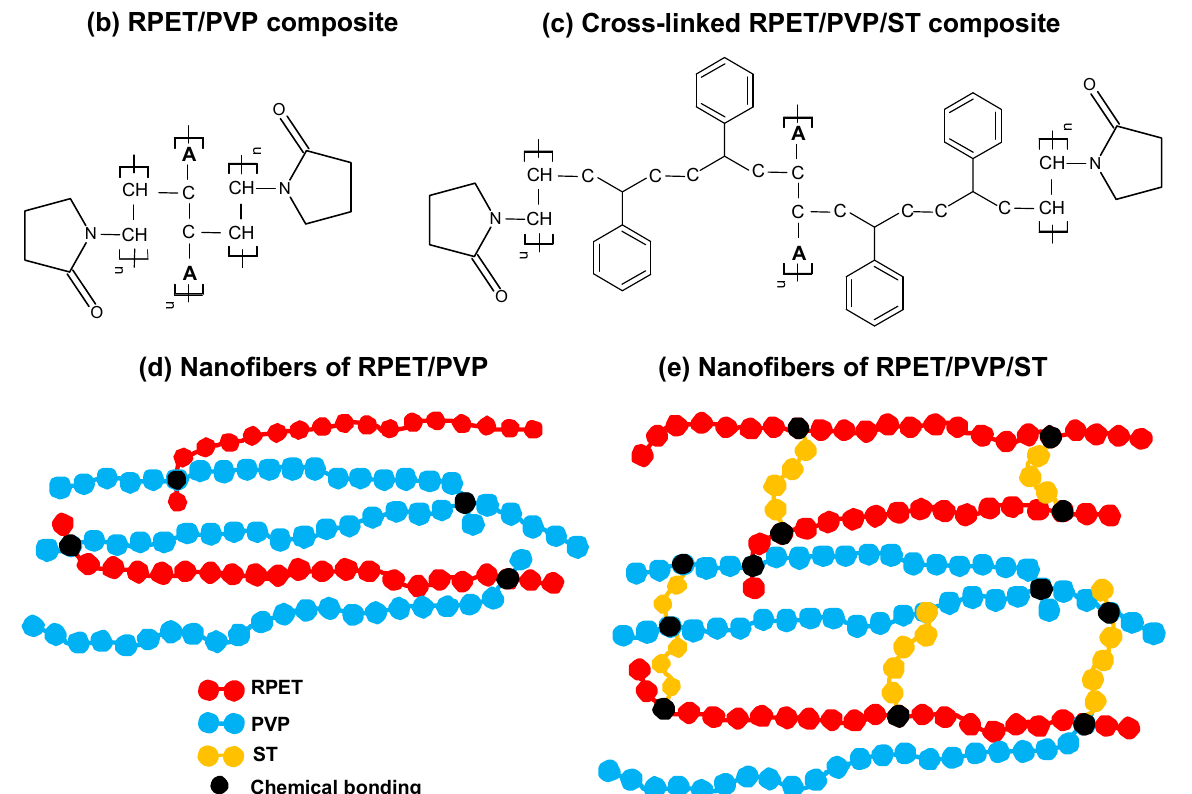
Figure 6. Mechanism of the reaction of nanofibers: ( a ) Generation of free radicals, ( b , c ) semideveloped chemical interactions, and ( d , e ) schematic representations of composite nanofibers.